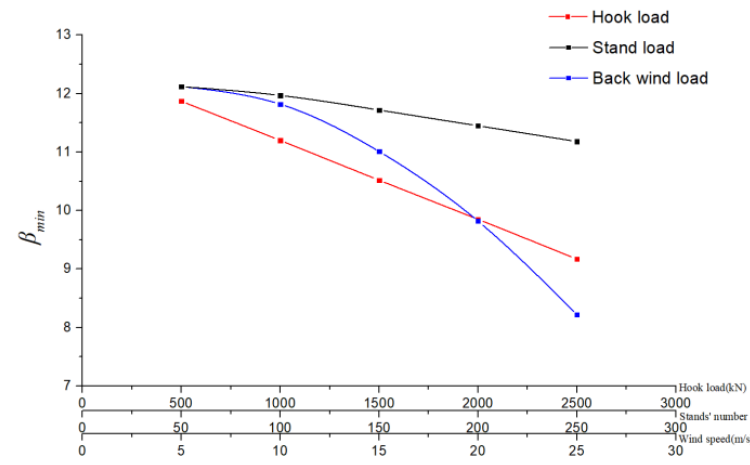
Figure 13. Influence of each load change on minimum reliability index under complex load.